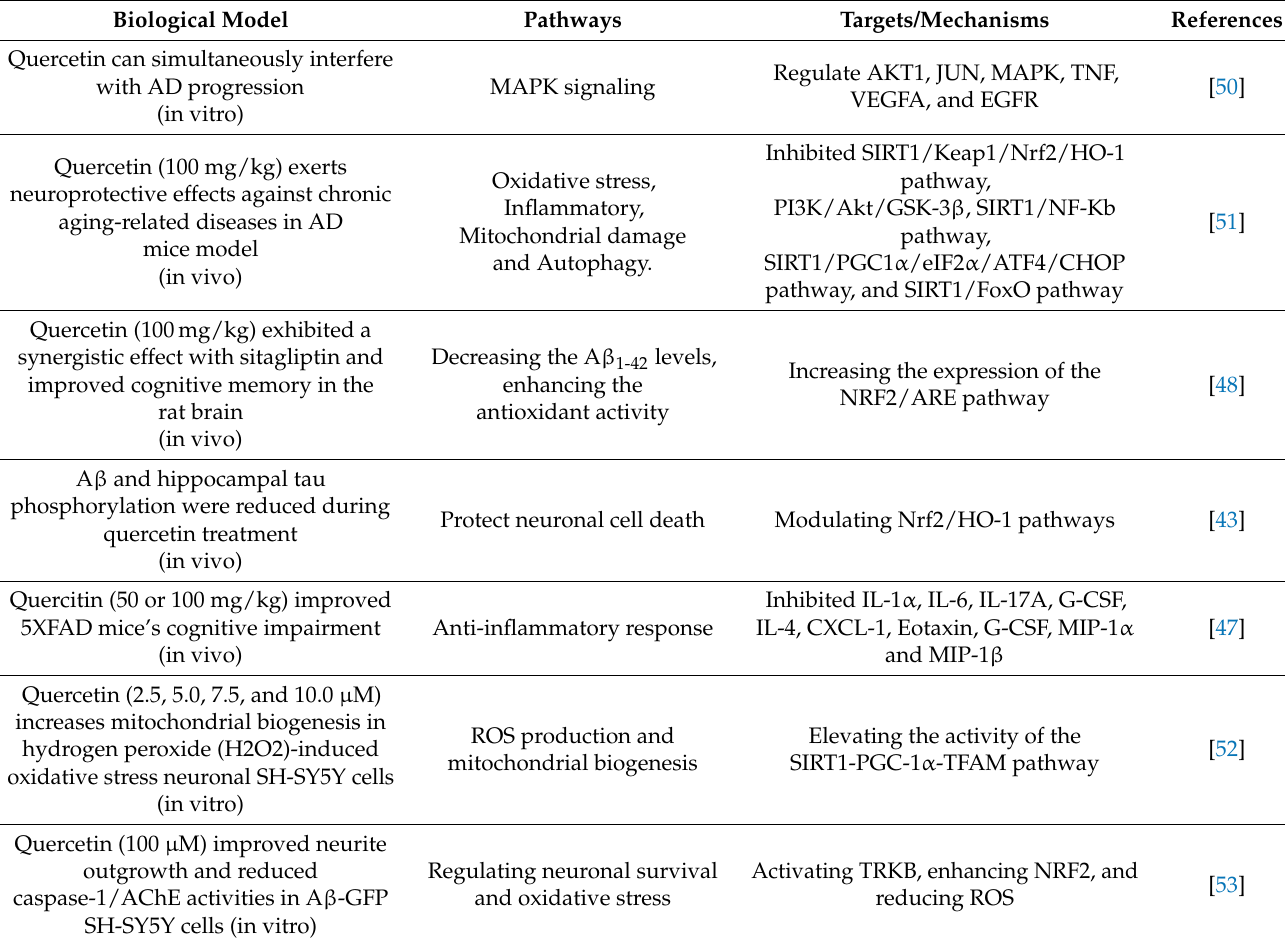
Table 1. Quercetin has neuroprotective and anti-inflammatory effects, reducing the production of pro-inflammatory cytokines in